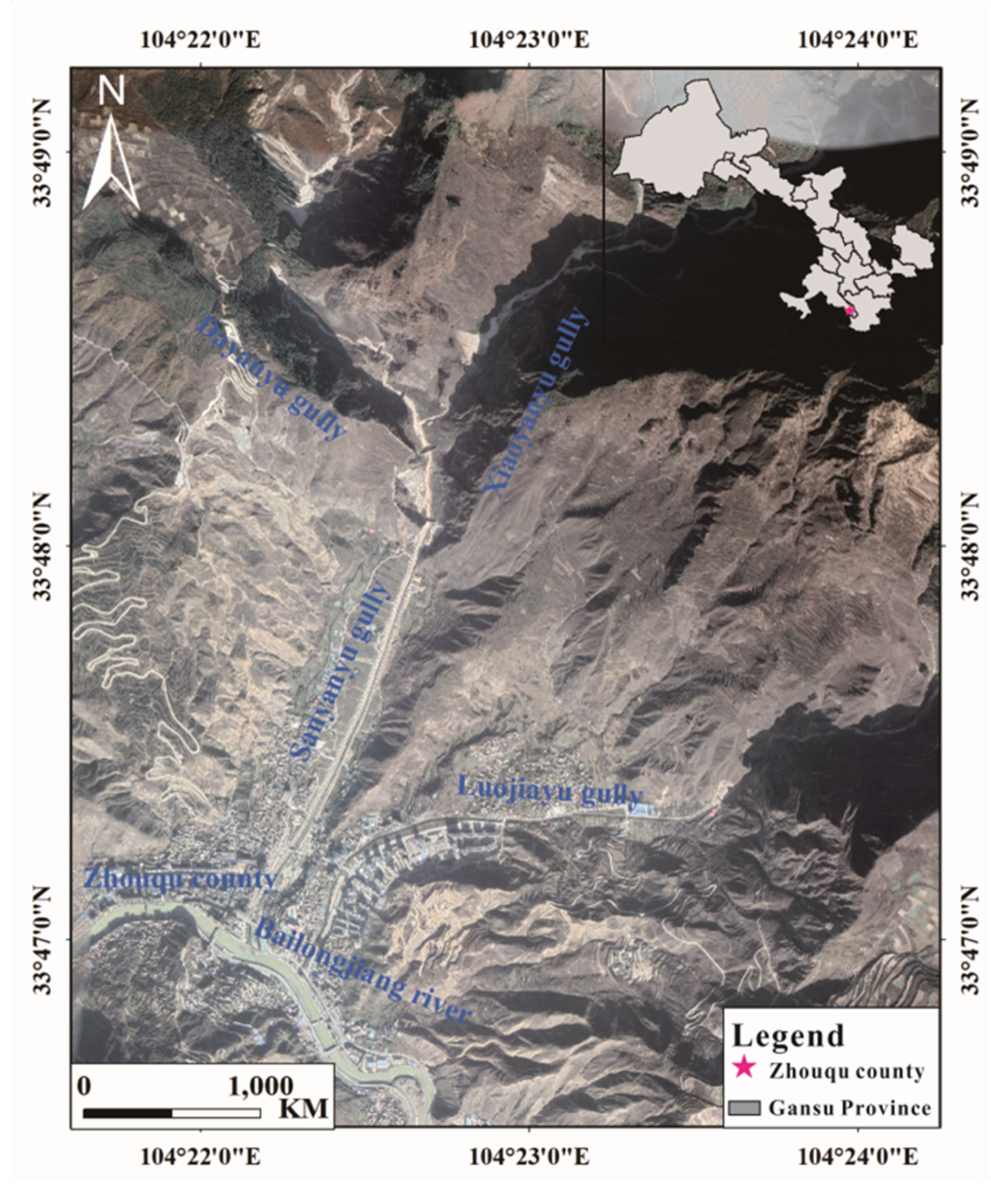
Figure 1. Location and terrain of the Zhouqu County (from Google Earth,